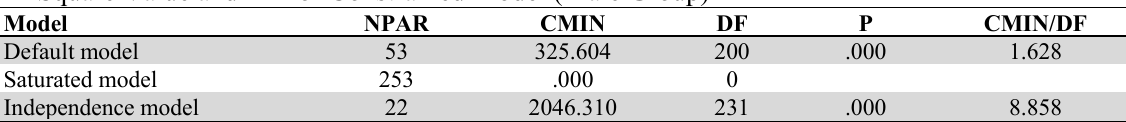
Chi-Square Value and DF for Constrained Model (Male Group) Model